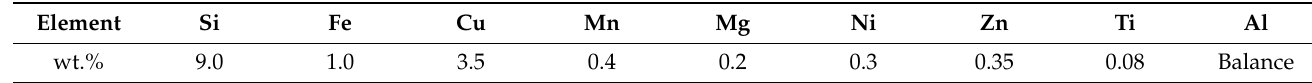
Table 2. Composition of the A380